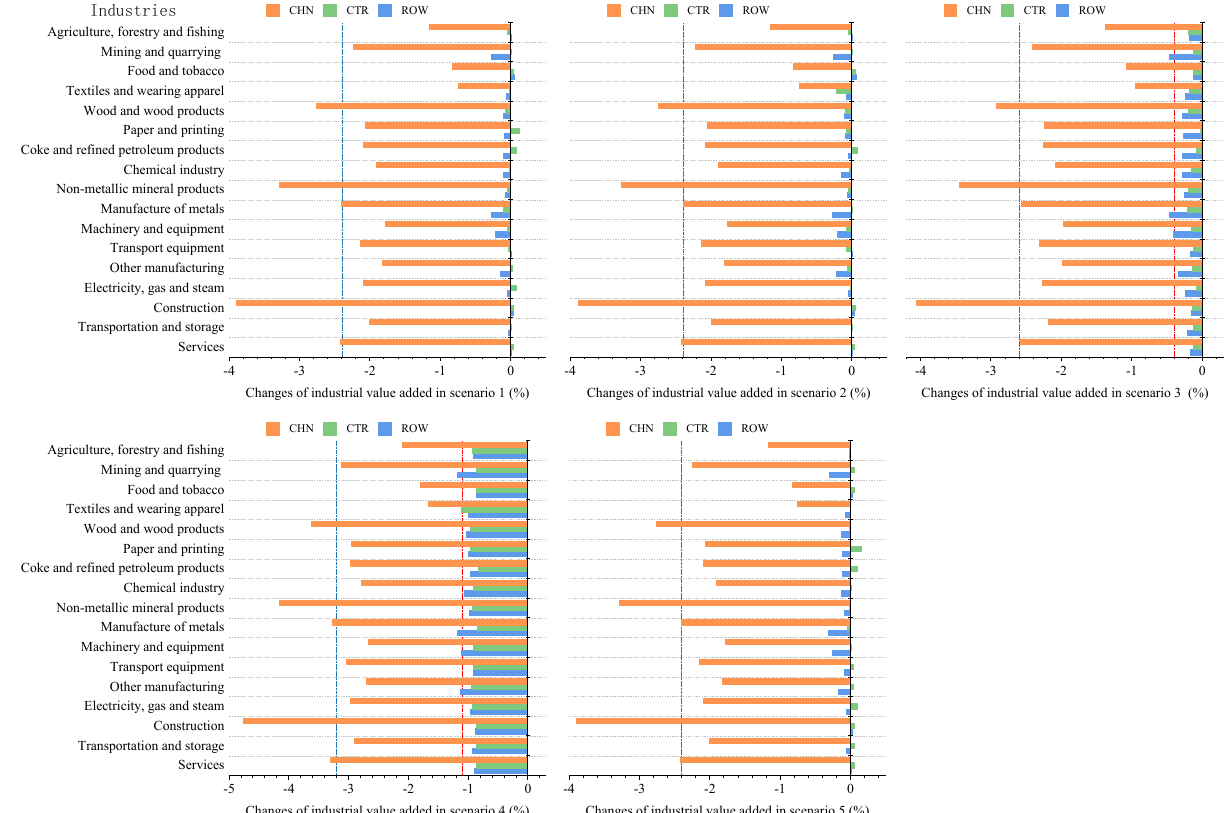
Figure 3. The impact of the COVID-19 outbreak in China on industrial value added in trade regions in the context of trade protectionism.